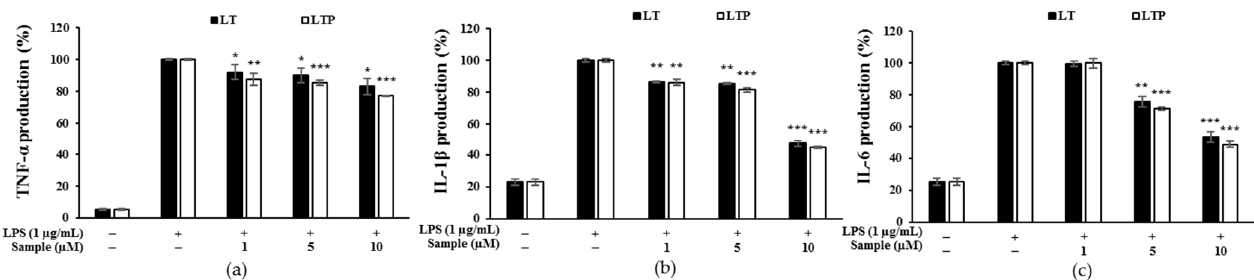
Figure 5. Comparison of the inhibitory effects of LT and LTP on LPS-induced ( a ) tumor necrosis factor- α (TNF- α ), ( b ) interleukin-1 β (IL-1 β ), and ( c ) interleukin-6 (IL-6) production in RAW 264.7 macrophages. Data are expressed as mean ± SD from three independent experiments (* p < 0.05, ** p < 0.01, and *** p < 0.001, compared to the LPS-treated group).